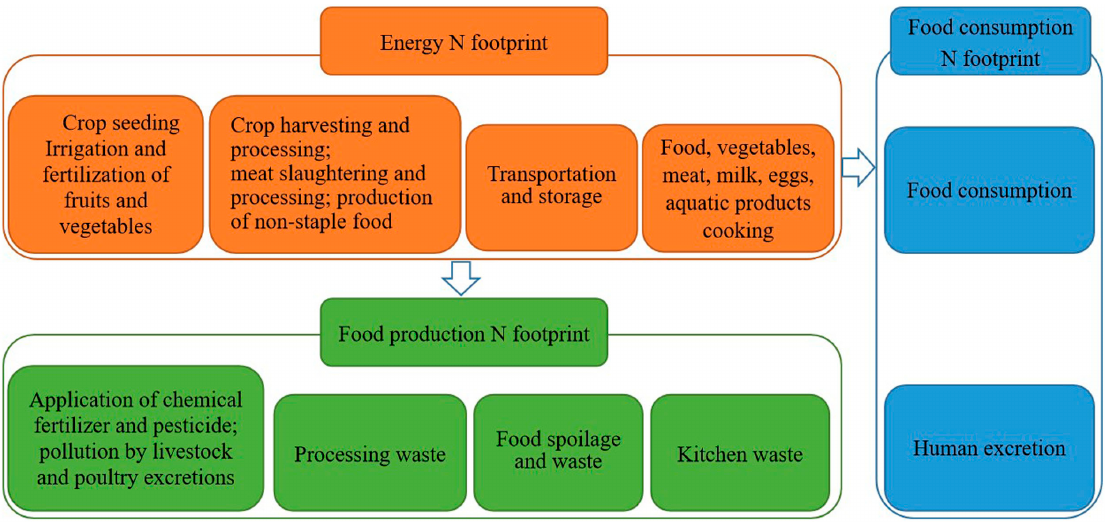
Figure 1. Nitrogen ( N) footprint during the food life cycle.